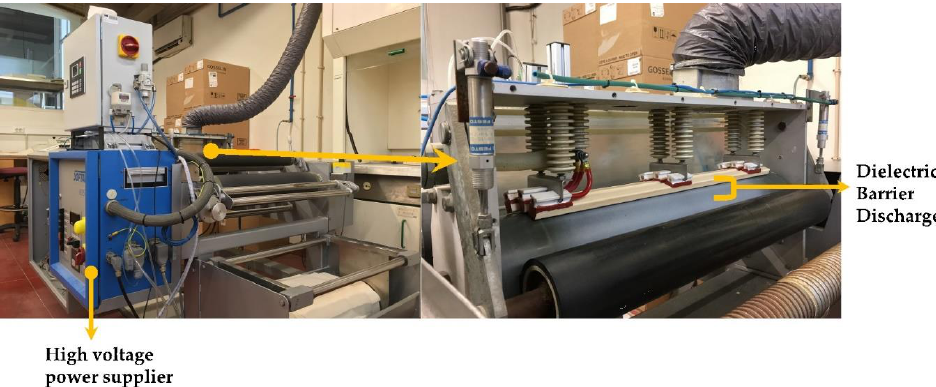
FigureA1. Figure A1. Schematic diagram with a photo of the DBD plasma equipment used for the sample treatment.